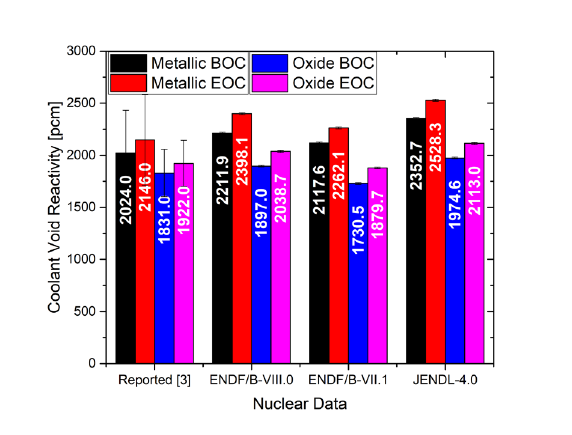
Figure 8. CVR of both cores for di ff erent nuclear data libraries